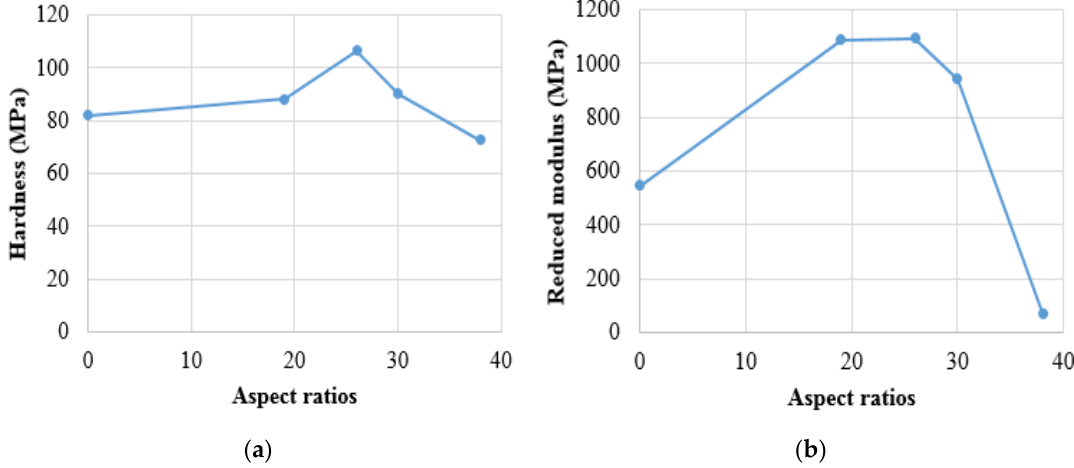
Figure 4. Effects of aspect ratios on ( a ) hardness ( b ) reduced modulus. Figure 4. E ff ects of aspect ratios on ( a ) hardness ( b ) reduced modulus.